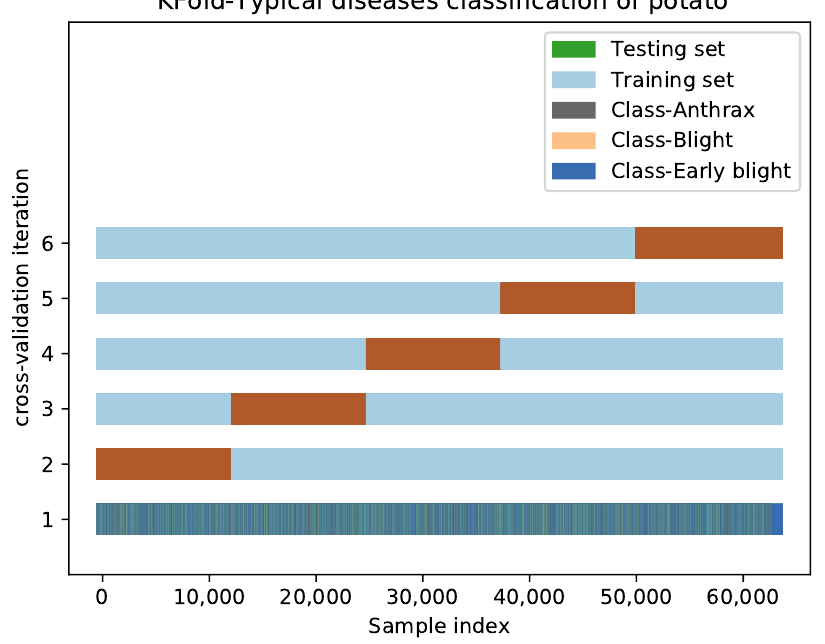
Figure 9. Data partition